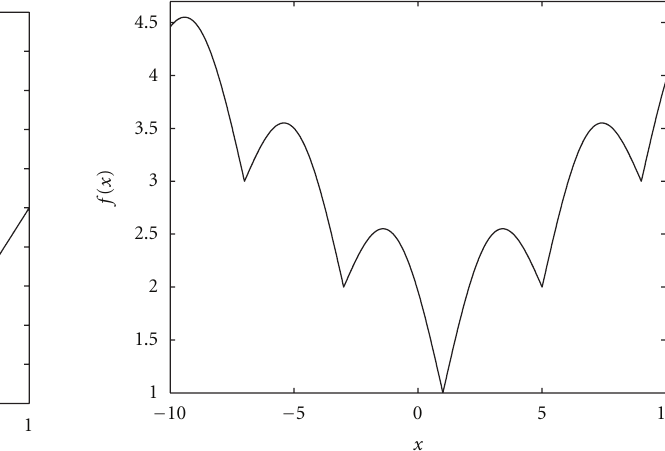
Figure 1: The graph of 𝑓(𝑥) of Example 1.